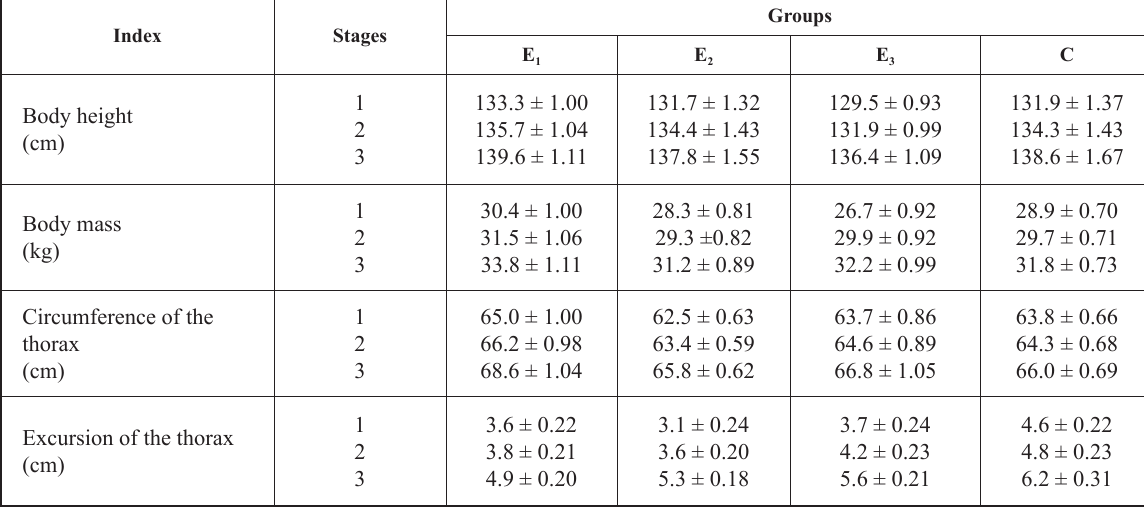
Table 1. Changes in the physical development of the tested groups (X ±